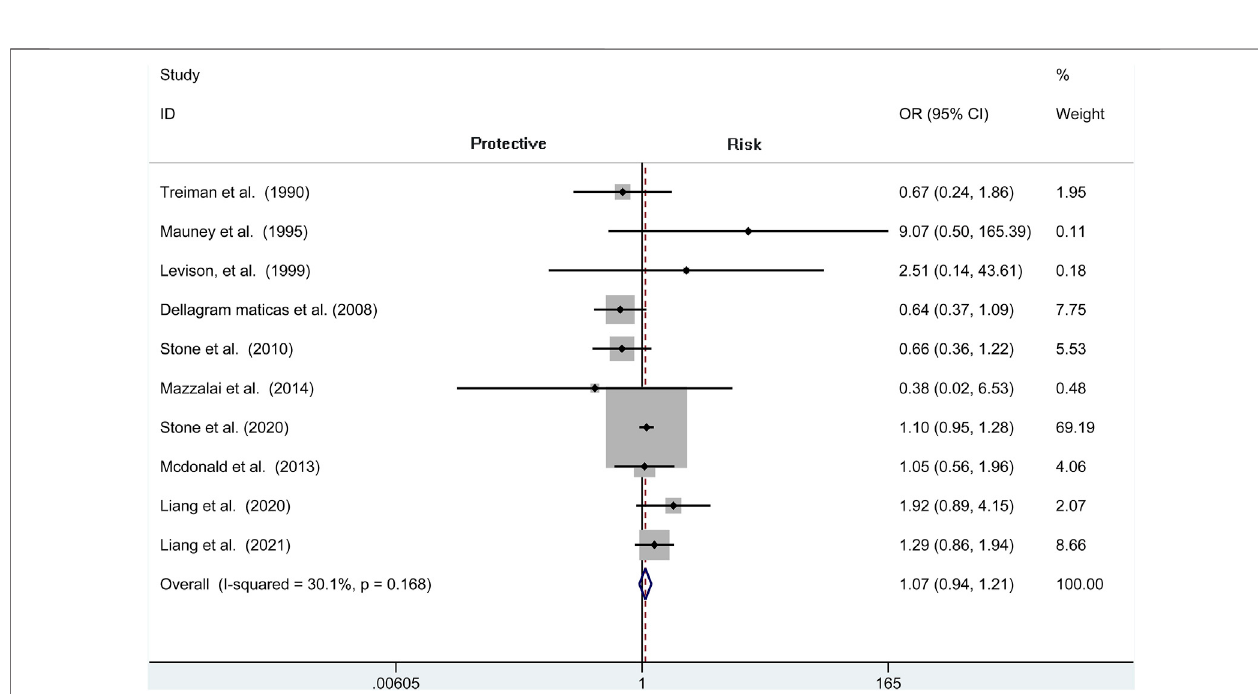
FIGURE 6 | Forest plot for meta-analysis of the incidence of wound hematoma with hypertension in the subgroup of CEA.